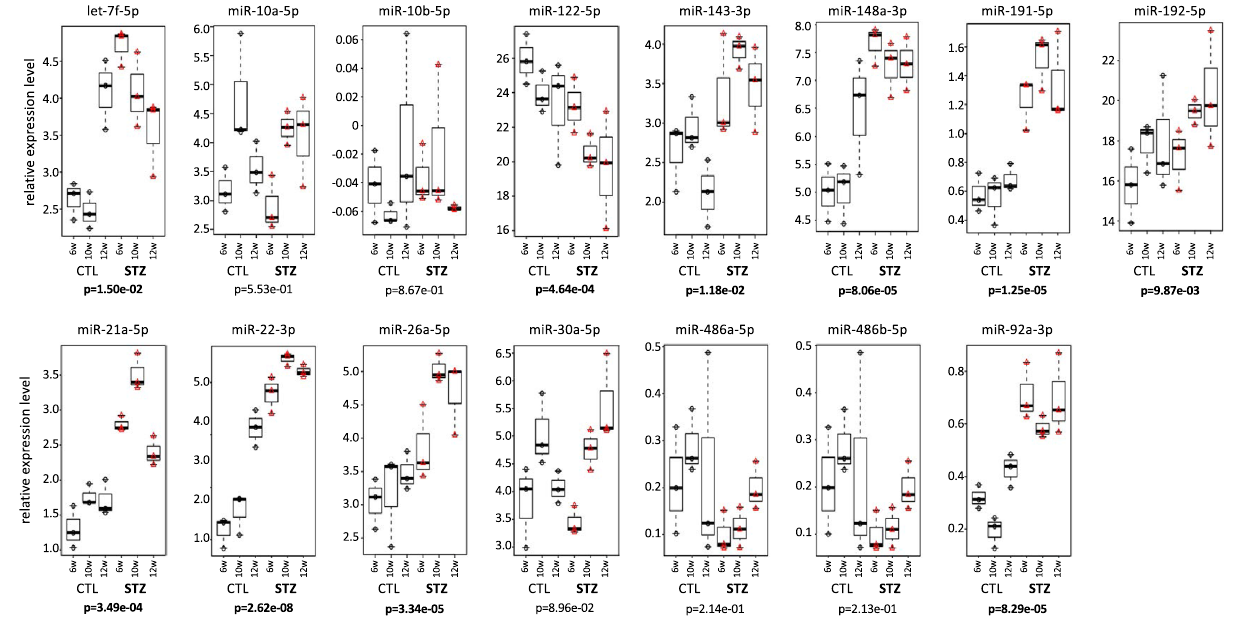
Figure 2. Expression pattern of miRNA in the liver. The expression level of 15 miRNAs in the liver from serial collection (6 W, 10 W, and 12 W) was shown in STZ-mice and in CTL-mice. Statistical analysis was performed using the student-t test, and a difference was considered statistically significant for a p < 0.05 (bold letter). The vertical axis represents the expression level of